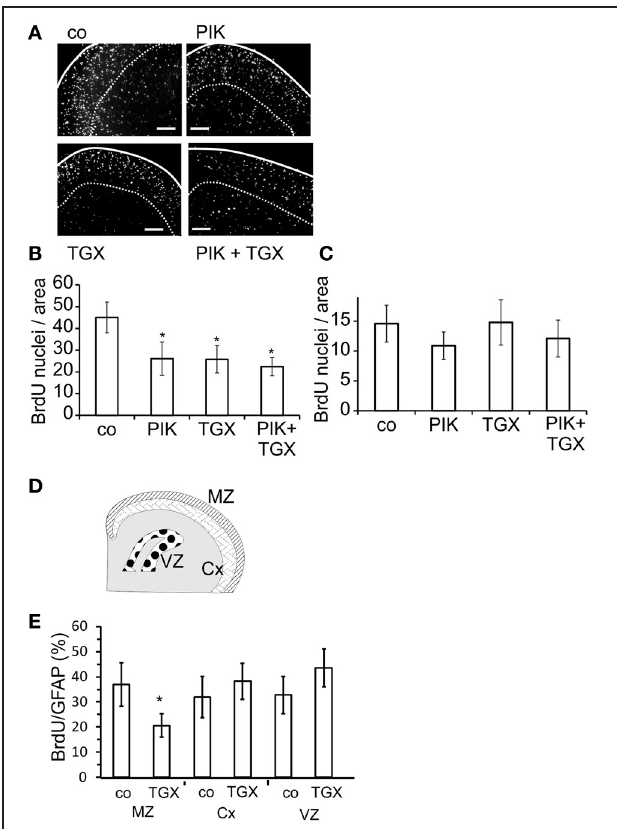
FIGURE 6 | Pharmacological inhibitors of p110 α and p110 β decrease the nuclear staining of BrdU in the marginal zone of the neocortex. After 3 days in culture, slice cultures of the neocortex were treated for 4 days with 200nM TGX-221 and/or 200nM PIK-75, an inhibitor of p110 α . (A) Micrographs of slices show BrdU stainings. Solid lines indicate pial surface; broken lines show the ventral border of marginal zone; calibration bars ∼ 200 μ m. (B) Quantitation of BrdU positive cells in the marginal zone. (C) Quantitation of BrdU positive cells in ventral layers of the neocortex. Means ± CI (0.95) are shown; n ≥ 17; ∗ ∼ p < 0 . 05 compared to controls. (D) Cartoon of the areas prepared shows marginal zone (MZ), deeper layers of neocortex (Cx), and ventricular zone (VZ). (E) Quantitation of nuclear staining of BrdU, which was compared to the number of GFAP positive cells. Means ± CI (0.95) are shown; n ≥ 8; ∗ ∼ p < 0 . 05 compared to